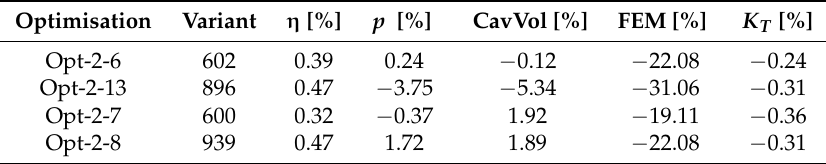
Figure 10. Cavitation performance of propeller case Opt-2; suction side sheet cavitation prediction by MPUF-3A. ( a ) Opt-2 baseline; ( b ) Opt-2-13. Table 6. Selected optimal solutions relative to baseline